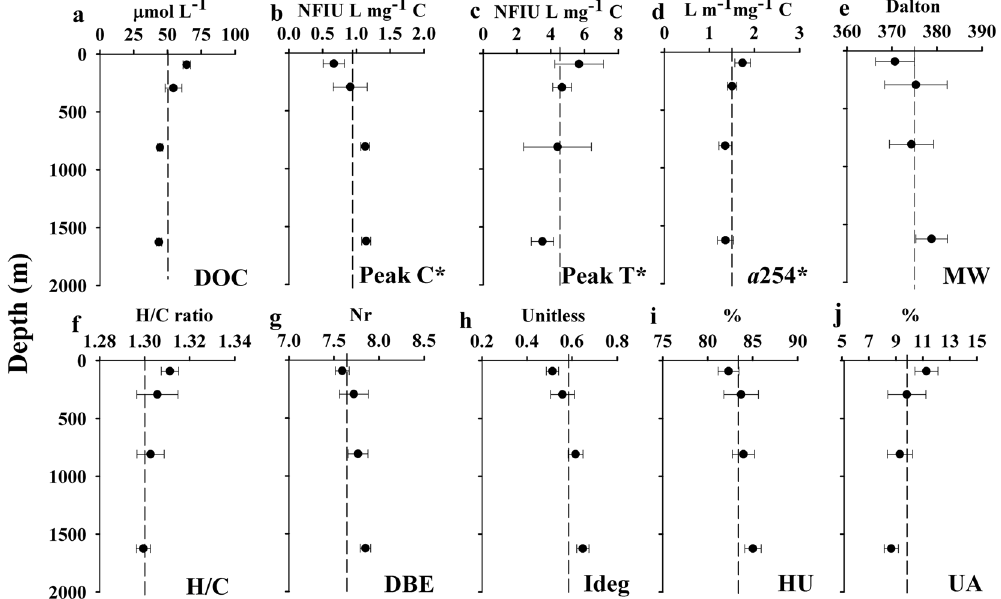
Figure 2. Vertical profiles of DOC, optical and molecular parameters averaged by water layer ( a ) DOC, ( b ) carbon-specific fluorescence intensity of humic-like substances (peak C * ), ( c ) carbon-specific fluorescence intensity of protein-like substances (peak T * ), ( d ) carbon-specific absorption coefficient at 254 nm ( a 254 * ), ( e ) average molecular weight (MW), ( f ) H/C ratio, ( g ) double bond equivalent (DBE), ( h ) degradation index (Ideg), ( i ) relative abundance of the highly unsaturated (HU) and ( j ) relative abundance of unsaturated aliphatic (UA) compounds. Error bars are standard deviation and the dashed lines represent the mean value for each variable. Figure created using the software Sigma plot (version